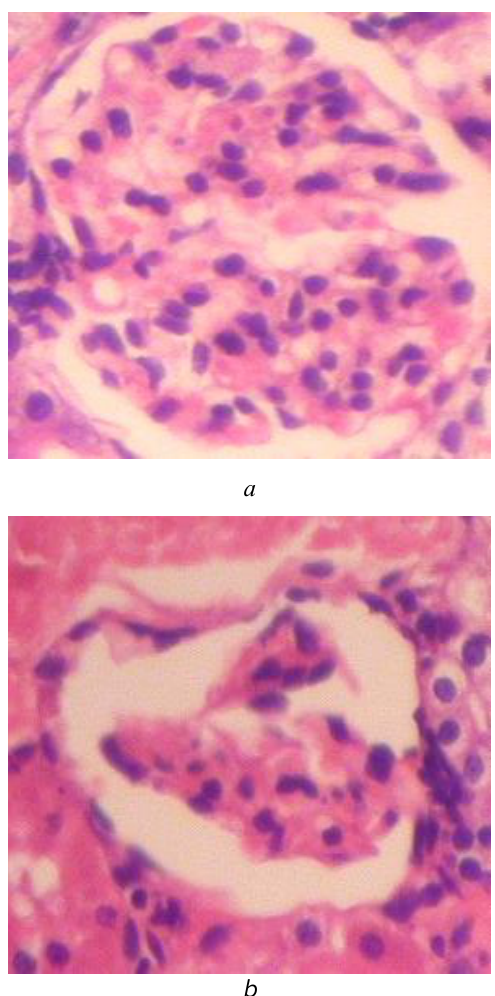
Fig. 4 Rat kidney with a model of glycerol acute renal failure on the background of the administration of “Indolinoren” on the 3rd day: a – kidney glomerulus corresponds to the norm; b – densely shaped kidney glomerulus, the pattern of capillary loops is not visualized. Hematoxylin-eosin. ×400 The data of the semi-quantitative assessment of the condition of the tubular apparatus of the nephrons also indicate that on the model of glycerol ARF, the Fig. 3. Rat kidney with a model of glycerol acute renal compound “Indolinoren” had a strong nephroprotective failure with the introduction of “Indolinoren” on the effect, significantly reducing the pathological changes in 3rd day: a – single-substituted convoluted tubules the system of tubular nephron compare to the control (arrows) on the background of intact; b – reduction of pathology (Table 1), reducing the severity of necrosis, cylinders in the channels of the cortico-medulla zone. vacuolic dystrophy and obstruction the lumen of the Hematoxylin-eosin. ×200 tubules by cylinders in 1.7 times. There is no reliable difference between the indicators for animals with ARF under the influence of the compound “Indolinoren” and furosemide comparison drug. Consequently, the new investigational compound “Indolinoren” on the severity of the normalizing effect on the histostructure of kidneys of rats with ARF is not inferior in compare to the loop diuretic